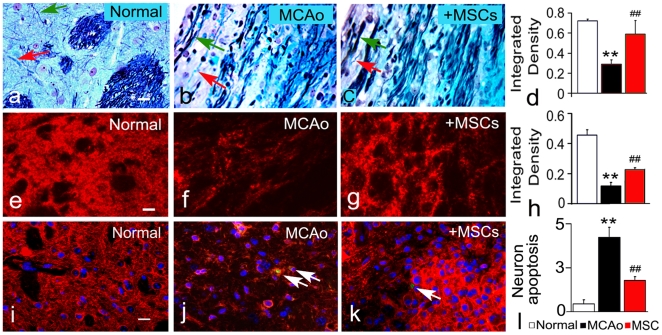
MSCs promote neurite outgrowth, synaptic plasticity and cell survival.Double staining (Bielshowsky, black for axons, indicated by green arrow; Luxol fast blue for myelin, indicated by red arrow.) shows axonal and myelin fibers in the striatum (b–c) along the IBZ after MCAo compared to normal brain (a). The integrated density (indicated the axonal and myelin fibers number) of white matter bundles in IBZ of striatum was decreased compared with that in normal brain, The axonal fibers and myelin of the striatum were enhanced by MSCs (c, d, Adjusted p-value = 0.0167). Immunofluorescent staining (e–g) shows synaptic regeneration (indicated by synaptophysin). Synaptophysin expression significantly increased in MSC treated rats (g, h, Adjusted p-value = 0.025). Apoptosis neuron (indicated by white arrow) is shown with double staining with TUNEL and MAP 2 (i–k), MSCs decreased the apoptosis neuron number (k, l, Adjusted p-value = 0.01667). Scale bars = 25 µm. **P<0.01, compared with normal mice; ##P<0.01, compared with control MCAo alone mice.